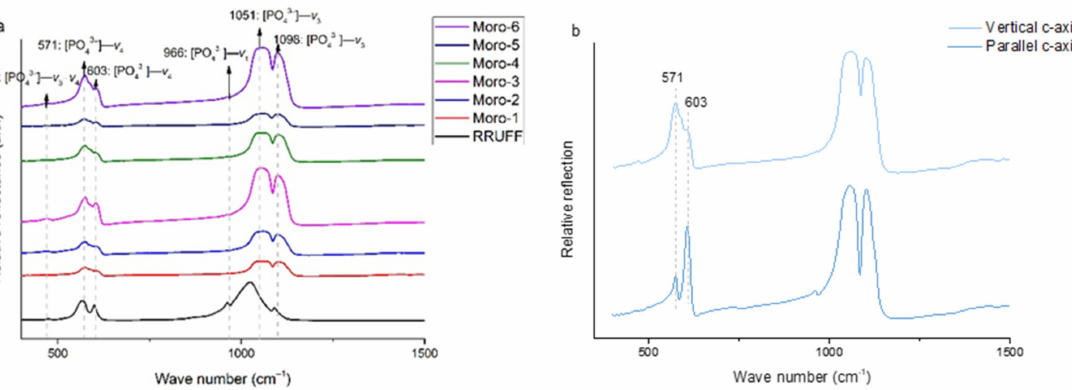
Figure 3. ( a ) Infrared spectra of the Moroccan apatites. ( b ) Infrared spectra of the Moroccan apatite at different